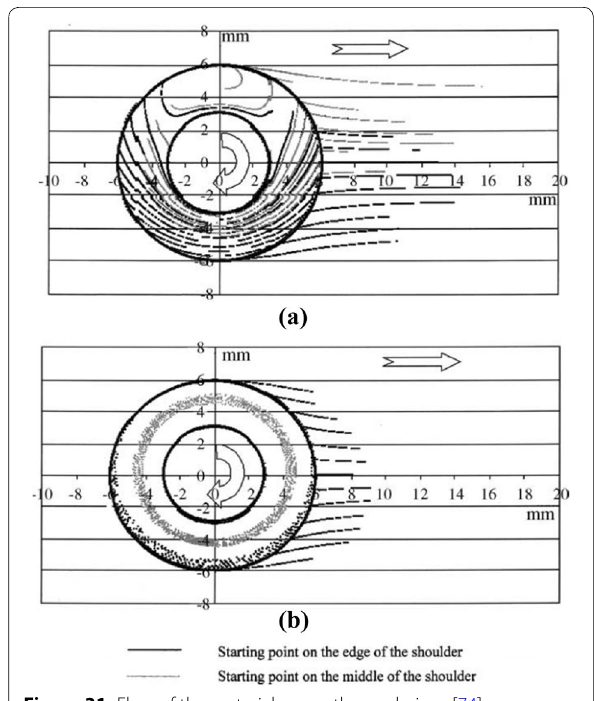
Figure 31 Flow of the material across the workpiece